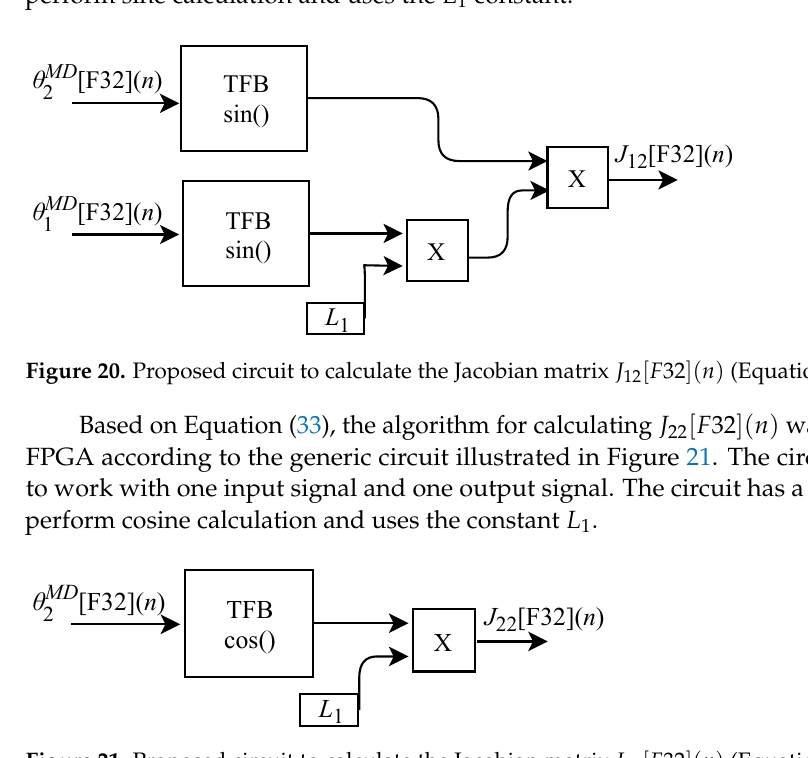
Figure 21. Proposed circuit to calculate the Jacobian matrix J 22 [ F 32 ]( n ) (Equation